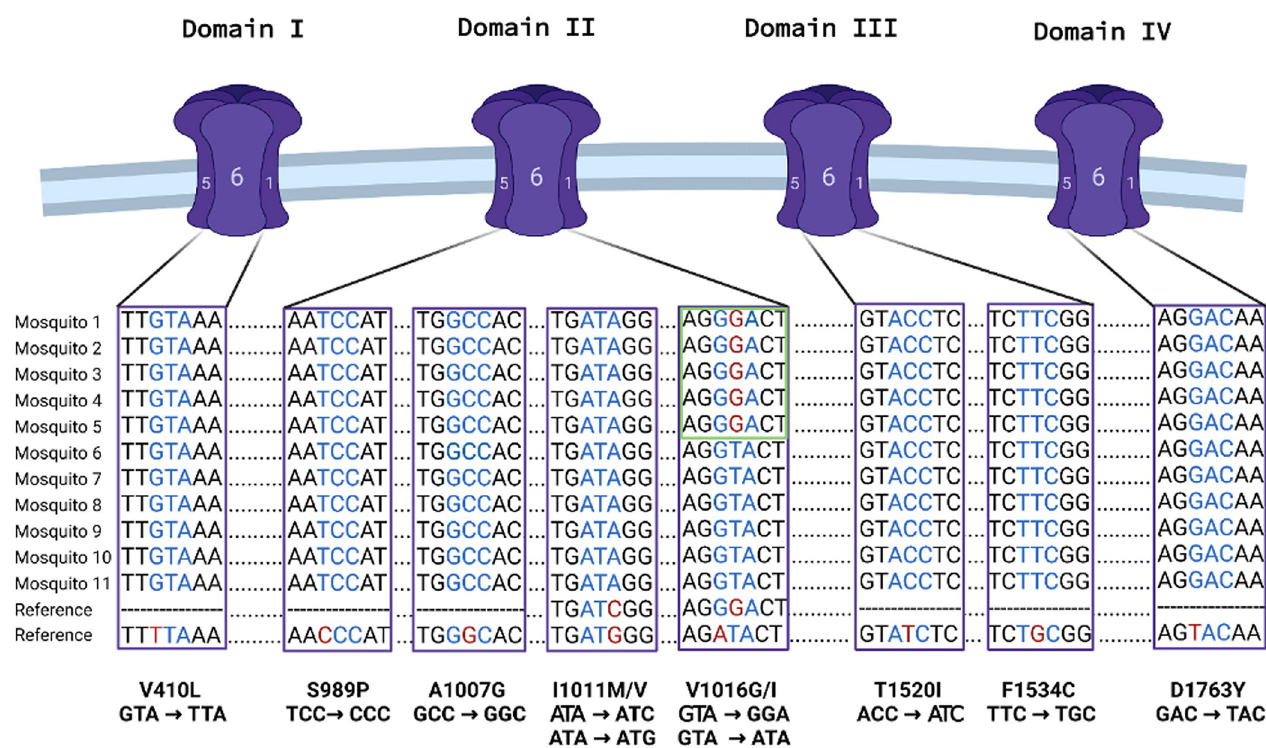
Fig 3. Alignment of eleven representative nucleotide sequences from DDT and deltamethrin resistant Ae . aegypti samples. The reference sequences are constructed to contain mutant codons and the sequence obtained from each of the VGSC structure domains (I—IV) are also shown. The green box highlights the five V1016G mutants detected through allele-specific qPCR in segment six (S6) of domain II that were verified by Sanger